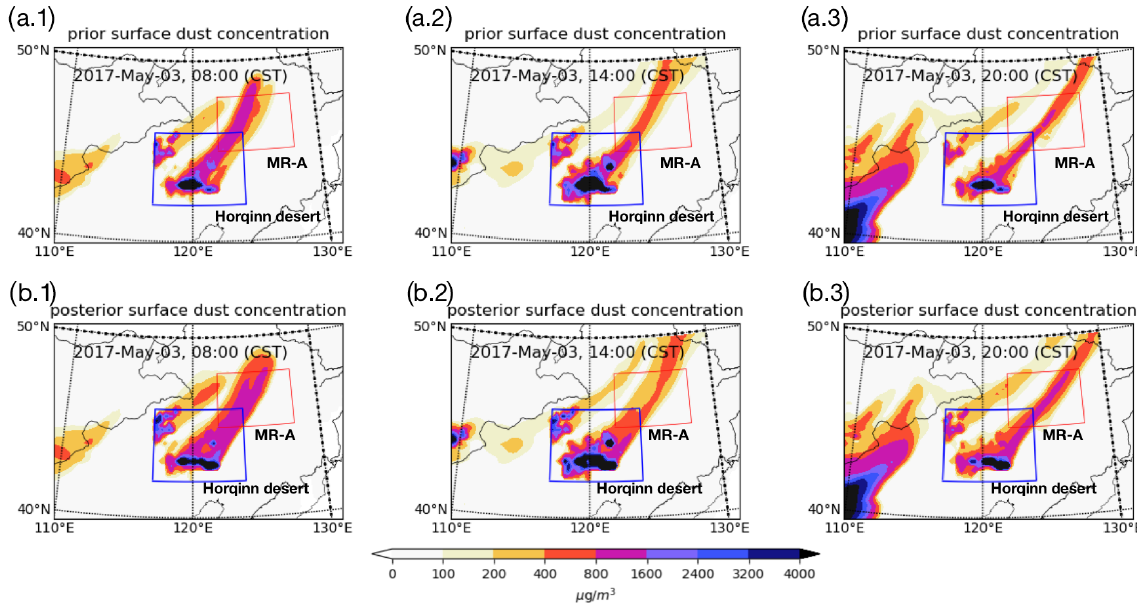
Figure 10. Simulation of SD1 using the new emission fields: (a) a priori and (b) posterior (by assimilating the Himawari-8 AODs) on 3 May, 08:00 (a.1–b.1) ; 14:00 (a.2–b.2) ; 20:00 (a.3–b.3) . MR-A: marked region A.